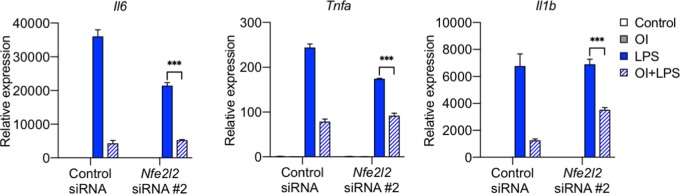
NRF2 is not required for the anti-inflammatory effects of exogenous itaconate (OI) on LPS-induced inflammatory response.qPCR of pro-inflammatory cytokine genes (Tnfa, Il6 and Il1b) in control or Nfe2l2 siRNA (#2) transfected BMDMs treated with LPS for 4 hours, with or without OI pretreatment (0.25 mM, for 2 hours). Significance of qPCR was analyzed with one-way ANOVA corrected with Bonferroni’s post hoc test for multiple comparisons, n = 3; *p<0.05, **p<0.01, ***p<0.001.